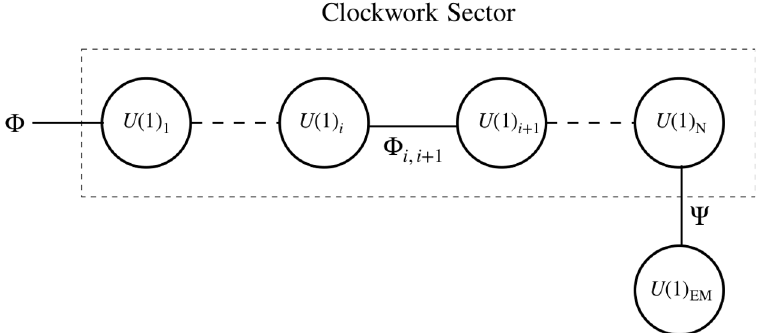
Figure 19 . The clockwork model that can generate a large kinetic mixing but a tiny dark photon mass. The various VEVs of scalars Φ i,i +1 break the U(1) N gauge groups in the dashed box down to a single dark U(1) D . The dark photon gets a mass from the VEV of the scalar Φ , while the fermion Ψ generates the kinetic mixing between U(1) D and U(1) EM